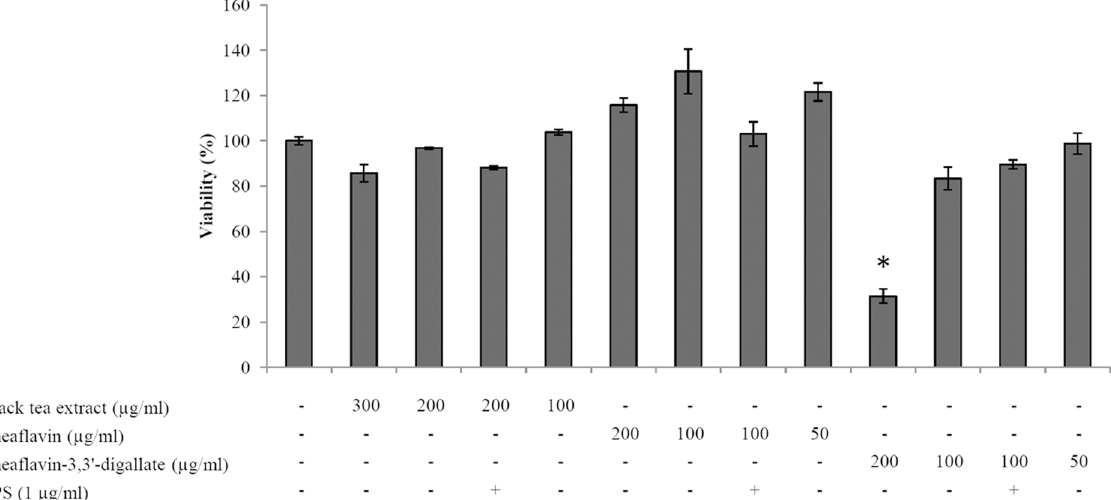
Fig 1. Effects of the black tea extract, theaflavin and theaflavin-3,3 ’ -digallate, individually or in combination with A . actinomycetemcomitans LPS on the viability of oral epithelial cells. * , significantly different from control at p < 0.01.